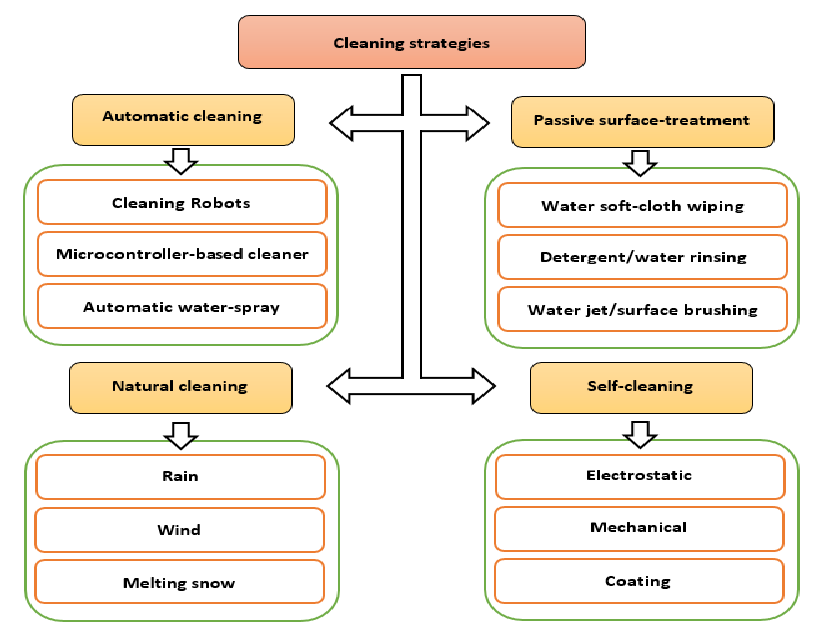
Figure 2. Different cleaning strategies for removing dust from solar PV panels.